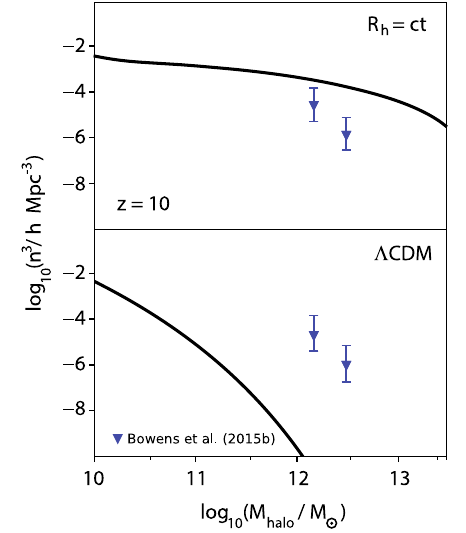
Fig. 7 Top: halo mass function inferred from galaxy surveys at z = 10 compared with R h = ct . Bottom: same, except now for Λ